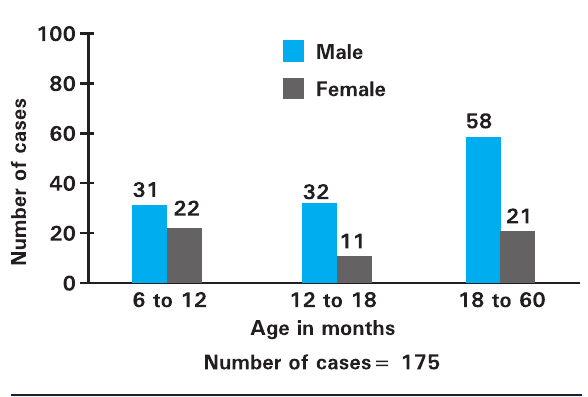
Figure 1. Distribution of cases according to age and gender Among the total cases, 30 cases (17.1%) had meningitis and 145 cases had febrile seizures. Out of the meningitis cases, 8 cases (4.5%) had culture positive bacterial meningitis (Figure 2).